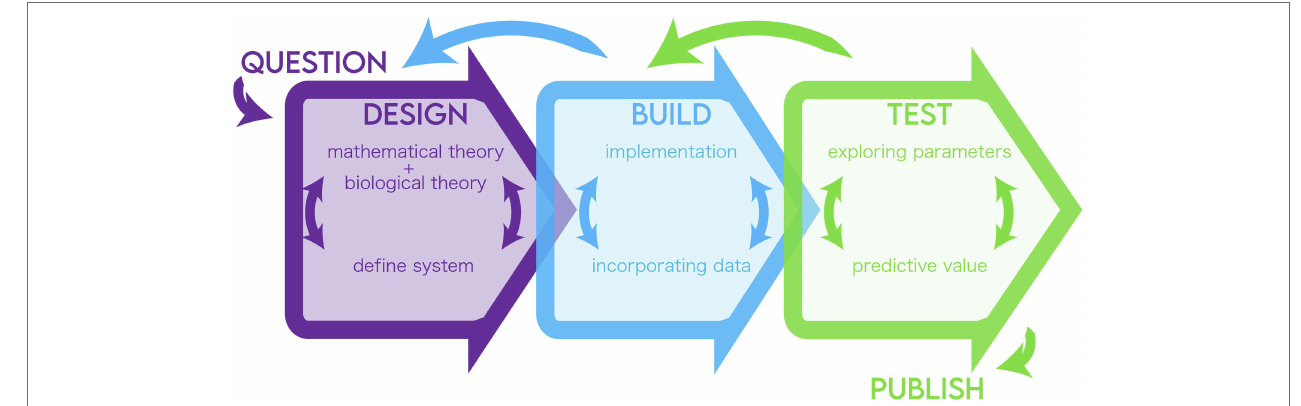
FIGURE 1 | Summary of the modeling life